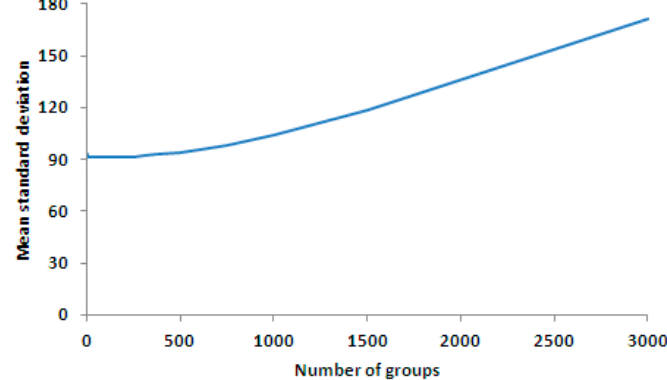
Figure 17. Mean value curve of the standard deviation of the corrected results for each line in various grouping cases. The smallest mean standard deviation is 91.02 at four groups. The horizontal axis is the number of groups, and the vertical axis is the precision of the correction result (mean standard deviation).